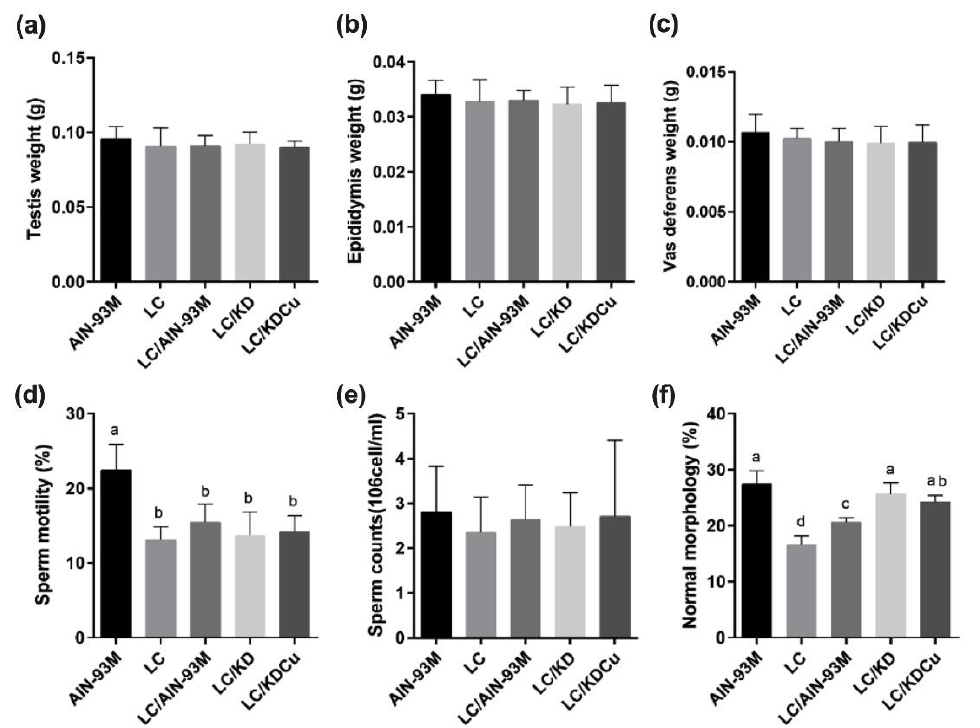
Figure 2. Effects of the low carbohydrate diet and curcumin on ( a ) testis, ( b ) epididymis, ( c ) vas deferens, ( d ) sperm motility, ( e ) sperm counts, ( f ) percentage of normal sperm morphology in male mice. Data are expressed as means ± SD. n = 11–12 per group. Bars ( a, b, c, d) with different letters indicate that values are significantly different. (One-way ANOVA, Duncan’s test, p < 0.05). AIN-93M: AIN-93M diet; LC: low carbohydrate diet; LC/AIN-93M: low carbohydrate diet changed to AIN-93M diet; LC/KD: low carbohydrate diet changed to ketogenic diet; LC/KDCu: low carbohydrate diet changed to ketogenic diet and curcumin.